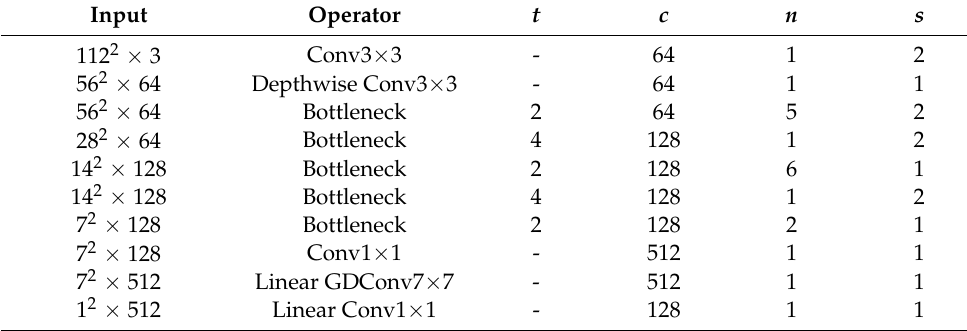
Table 1. MobileFaceNet architecture